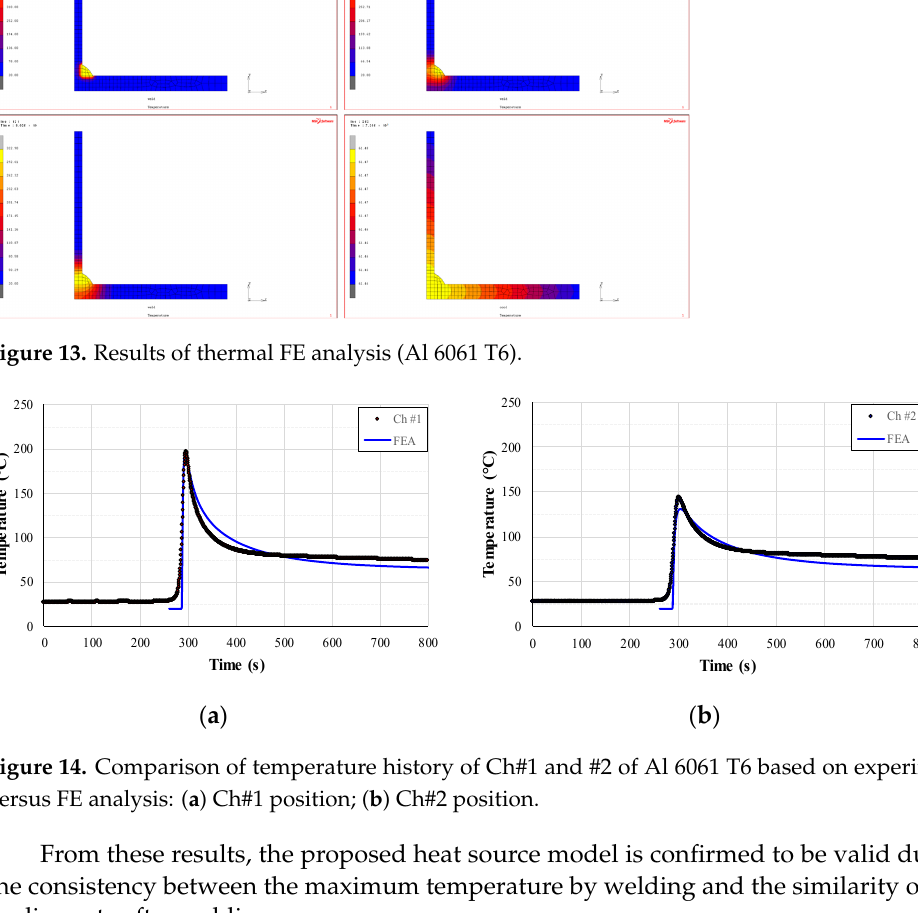
Figure 15. HAZ Verification Al 6061 T6 (macro section vs. FE analysis). 3.2. FE Analysis of Welding-Induced Residual Stress Residual stress is inevitably generated during structural welding due to periphery restraint, thermal expansion and contraction, elastic/plastic deformation and material phase transformation. Several methods are used to measure welding-induced residual stresses. In this study, the hole drilling method, which is a destructive residual stress measurement method, was used. The measured residual stress values were compared and verified with the precise thermo–elastic–plastic FE analysis proposed in this study. As mentioned above, the FE analysis method used in this study is a 3D thermo–elas- tic–plastic mechanical analysis. Welding is a very complex physical phenomenon, and knowledge of materials, heat transfer and solid mechanics must be combined and ana- lyzed. In particular, all material properties should use a temperature-dependent value. This is because welding occurs from room temperature to the melting point of the metal, and the physical properties change for each temperature, and expansion/shrinkage of the